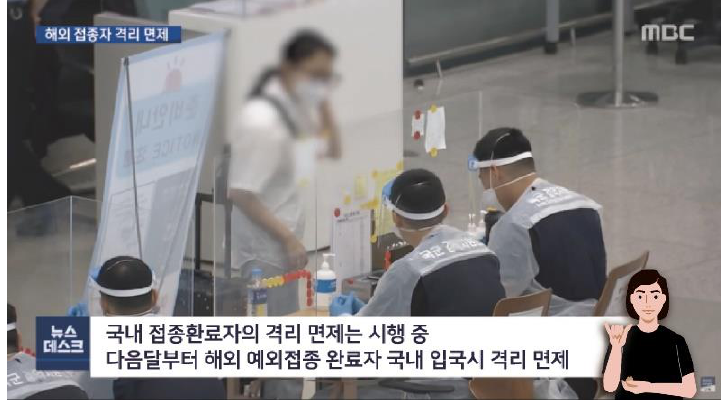
Figure 23. Proposed layout design of information delivery components for news type broadcasts.